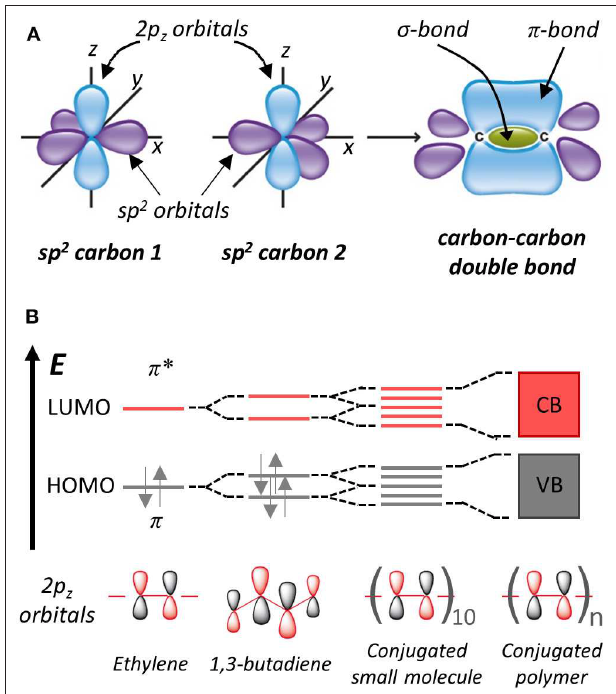
FIGURE 2 | (A) A schematic illustration of hybridized sp 2 and unhybridized 2 p z orbitals combining to form a σ -bond and a π - bond in a carbon–carbon double bond. (B) An extension of molecular orbitals to long conjugated oligomers and polymers indicating the origin of band structures (VB, valence band; CB, conduction band) in organic